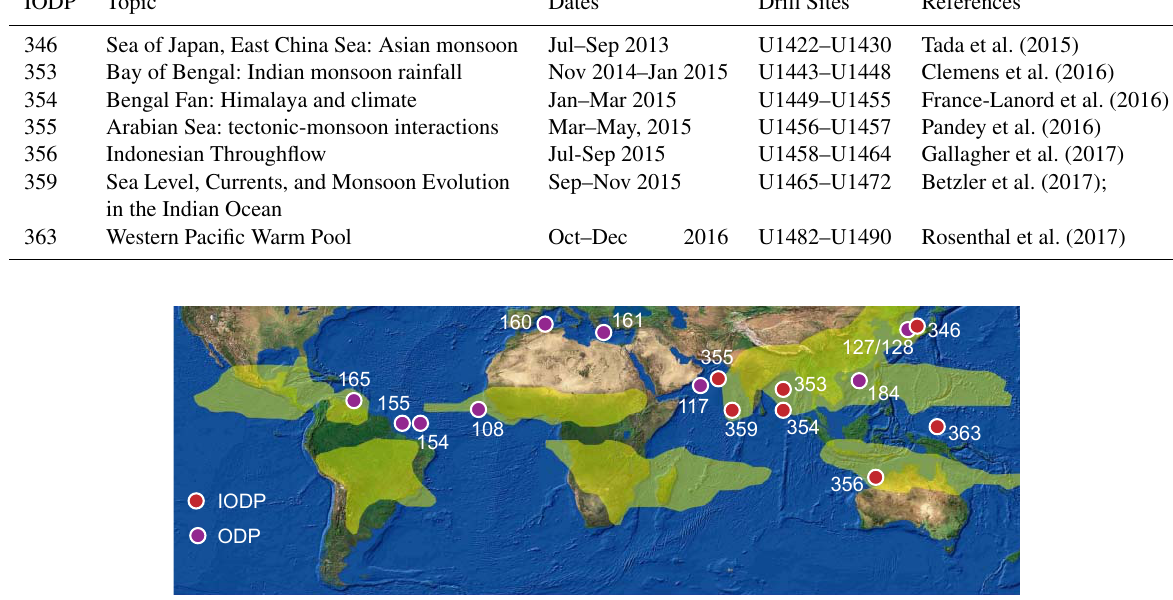
Figure 1. IODP/ODP monsoon expeditions.